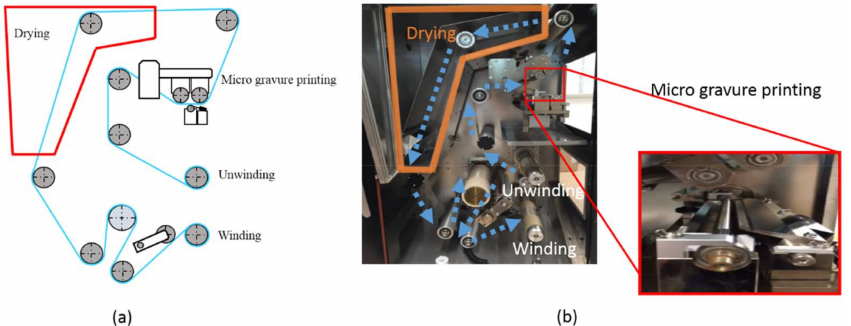
Figure 1. ( a ) Schematic diagram thin film coating machine; ( b ) thin film coating machine (NMC-350 YASUI SEIKI, Nagasaki,